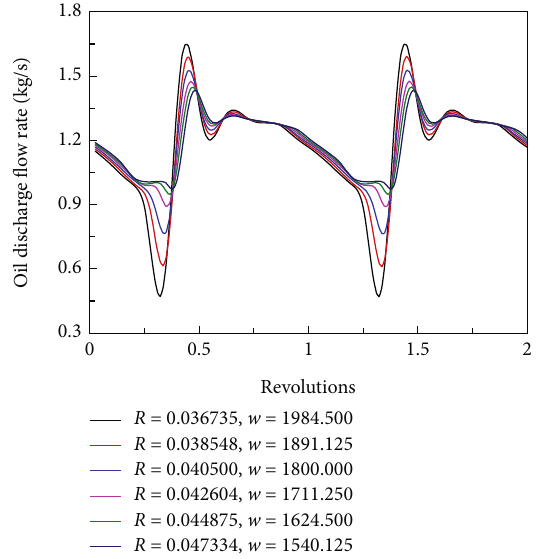
Figure 15: The fl ow rate curves of the outlet port with di ff erent distribution circle radii and rotation speeds.